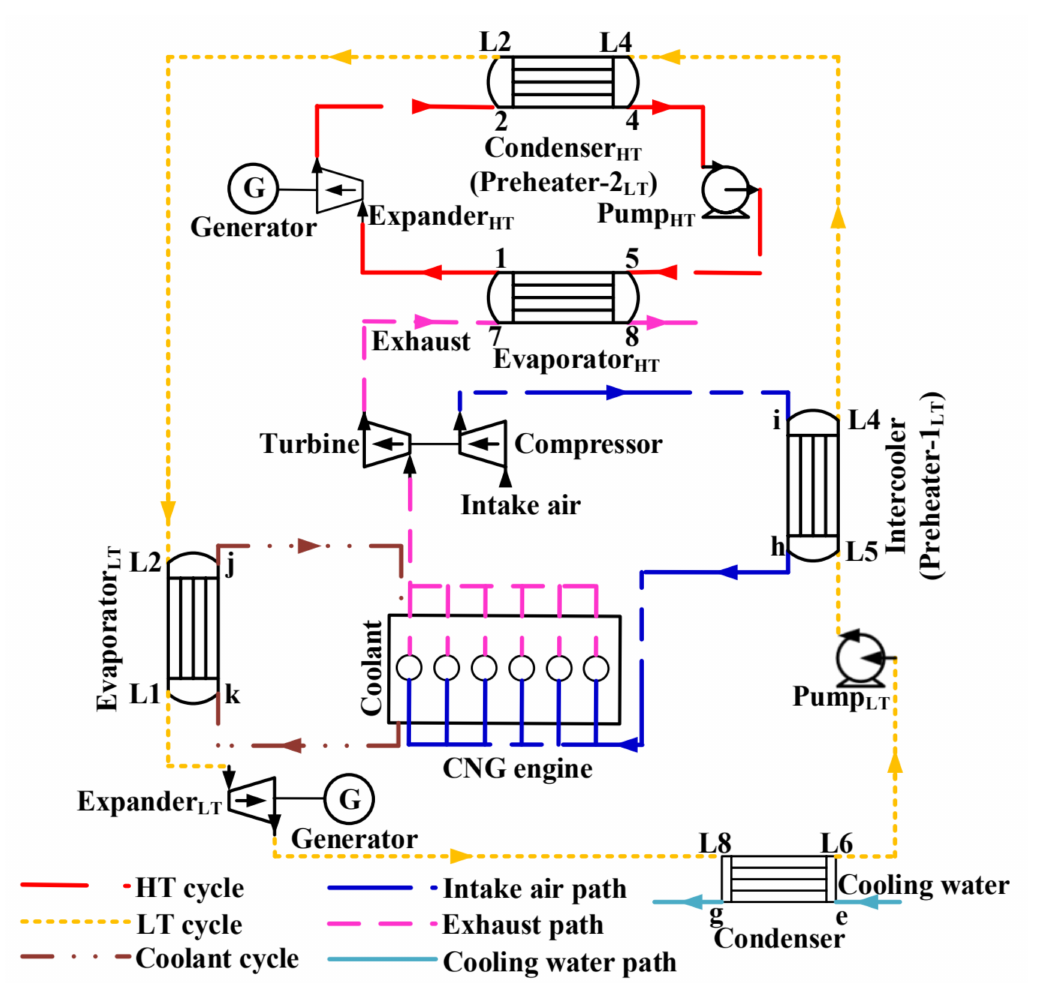
Figure 1. Schematic of the DORC